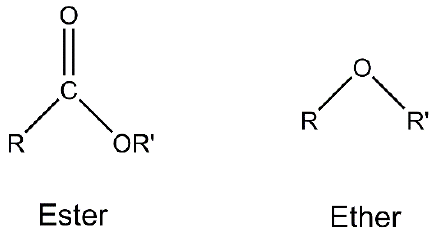
Figure 5. Ester and ether